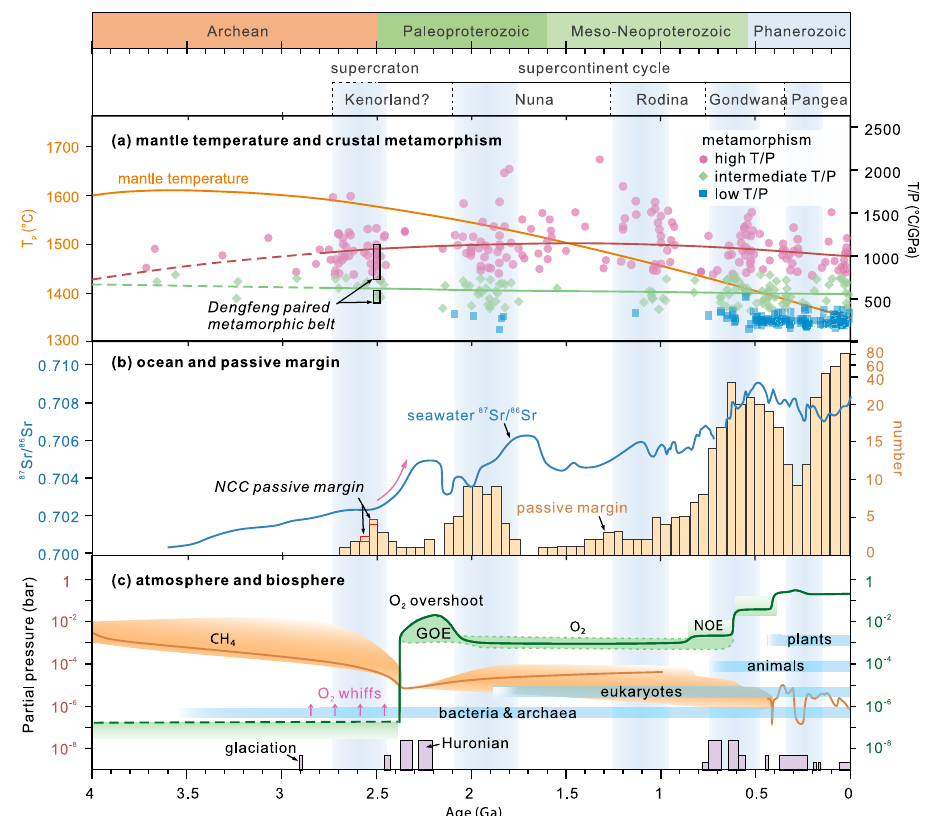
Fig. 8 | Geological proxies for the secular evolution of mantle temperature, crustal metamorphism, ocean, atmosphere and biosphere. a Mantle tempera- ture and crustal metamorphism 1,55 . The ca. 2.5 Ga Dengfeng paired metamorphic belt 22 in the Central Orogenic Belt of the southern NCC is identi fi ed. b Seawater 87 Sr/ 86 Sr isotopes 61 , and the age distribution of passive margins 45 . Note that the Neoarchean passive margin in the NCC represents one of the oldest passive mar- gins on Earth 45 . The red arrow highlights a signi fi cant increase of seawater 87 Sr/ 86 Sr